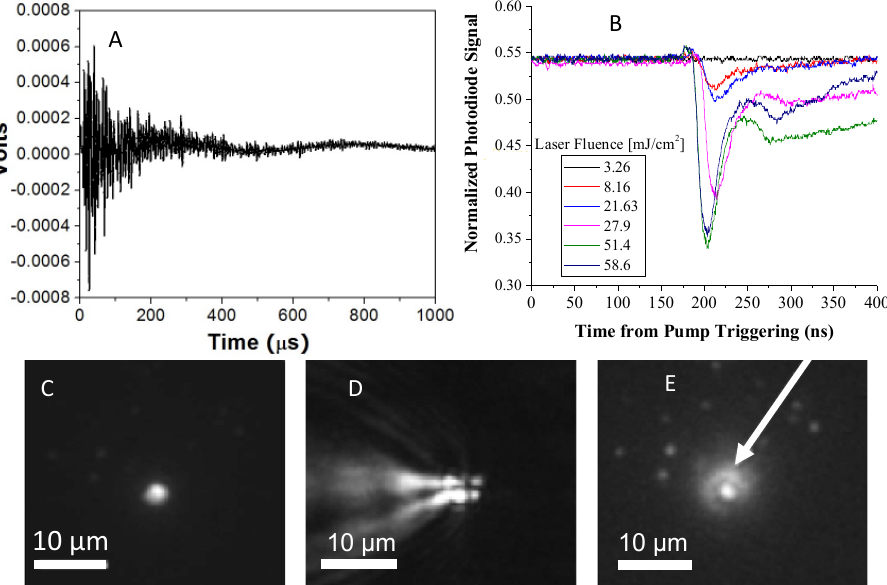
Figure 11. ( A ) Hydrophone voltage variations corresponding to pressure changes in a solution of HGN following irradiation with pulsed NIR light. The pressure variations correspond to the formation and collapse of nanobubbles, similar to the pressure variations induced by cavitation bubbles during sonication. Figure adapted from [51]. ( B ) The decrease in photodiode signal of a continuous laser probe beam is due to the scattering from the nanobubbles and increases with increasing laser fluence consistent with larger or more numerous nanobubbles. A fluence of ~3 mJ/cm 2 is not sufficient to induce nanobubbles, and there is no change in the probe signal (black trace). Higher fluences show the decrease in signal with a threshold fluence of ~8 mJ/cm 2 for nanobubble formation (red trace). Adapted from [45], published by Wiley, 2018. ( C ) Optical microscope image of fluorescently labelled liposome tethered to a glass coverslip. ( D ) Ten nanoseconds after pulsed NIR laser showing the formation of a liquid–vapor jet due to the rapid expansion and collapse of the nanobubble. The jet induces mechanical stress to the liposome membrane as in sonication, as in Figure 2. Bar is 10 µm. ( E ) Fluorescent dye is released from the liposome in C after 10 msec (arrow). Adapted with permission from [8], published by Elsevier, 2010.